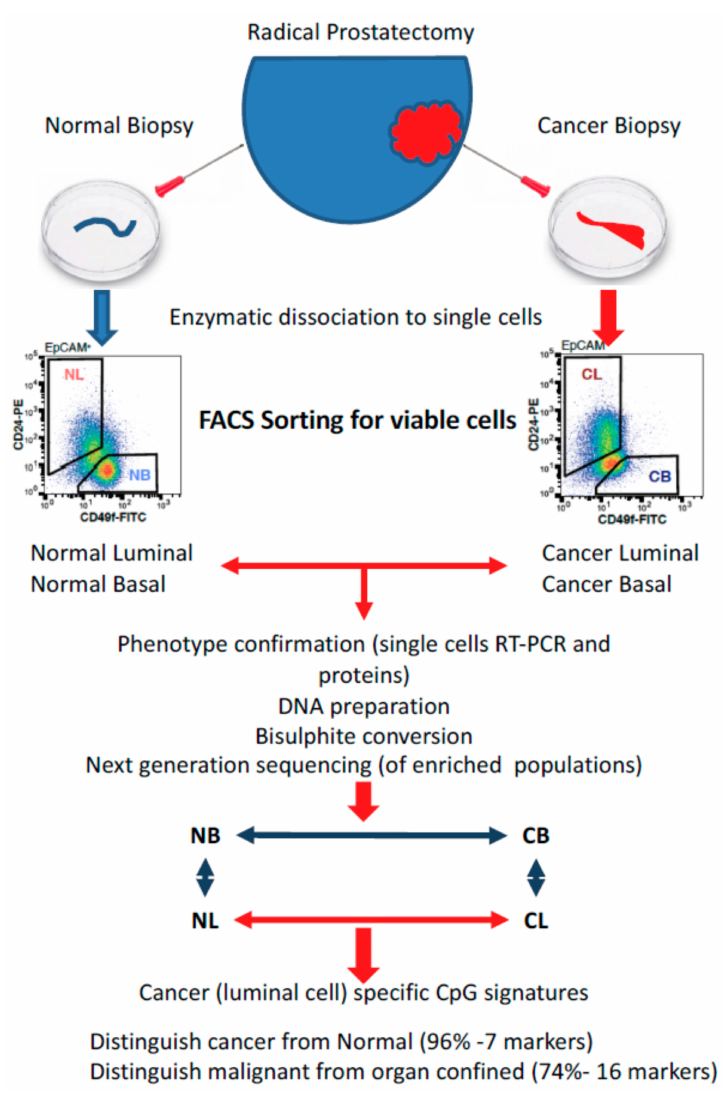
Figure 4. Fractionation strategy for genomic methylation analysis of discrete cell subpopulations from the prostate. Fractionation from total tissue biopsies as described in the text eliminates the influence of dominant cell populations and also eliminates artefacts of in vitro cell culture